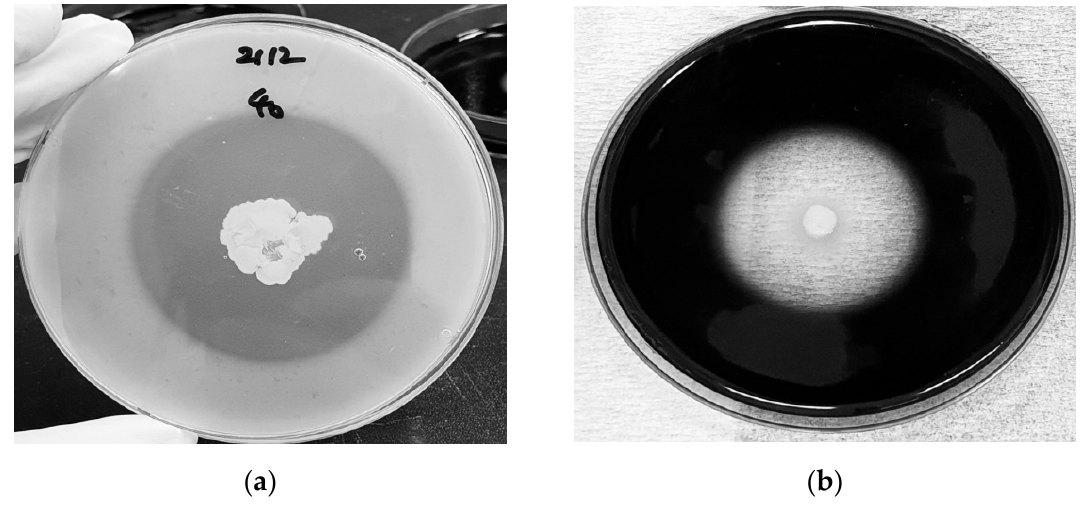
Figure 2. The protein ( a ) and starch ( b ) degradation of strain FW2 incubated at 45 °C for 4 days. The largest sizes of halo zones were 52 mm and 43 mm for protein and starch degradation, respectively, at 45 °C for 4 days (Figure 3).